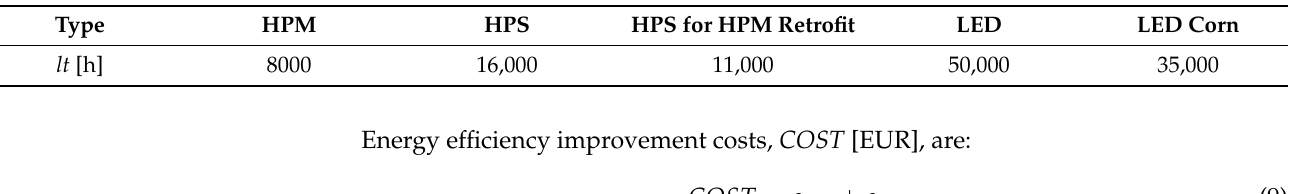
Table 4. The lifetime of different lamps.